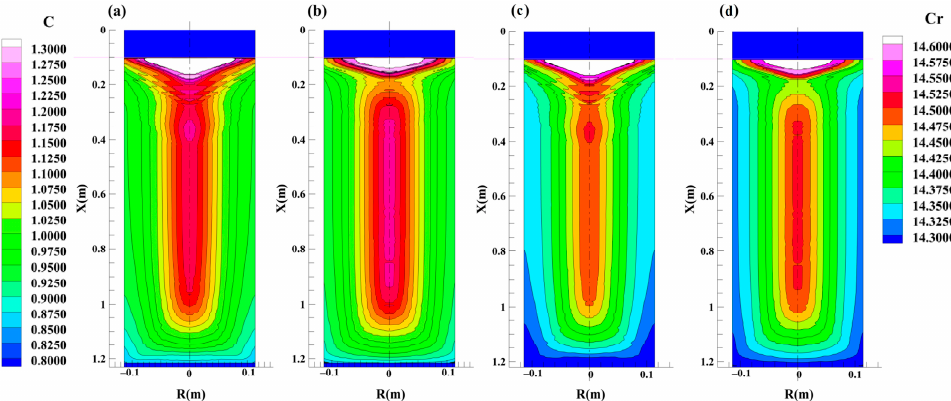
Figure 20. Distribution of C and Cr concentration with varying filling ratio: ( a ) C concentration, 0.16,